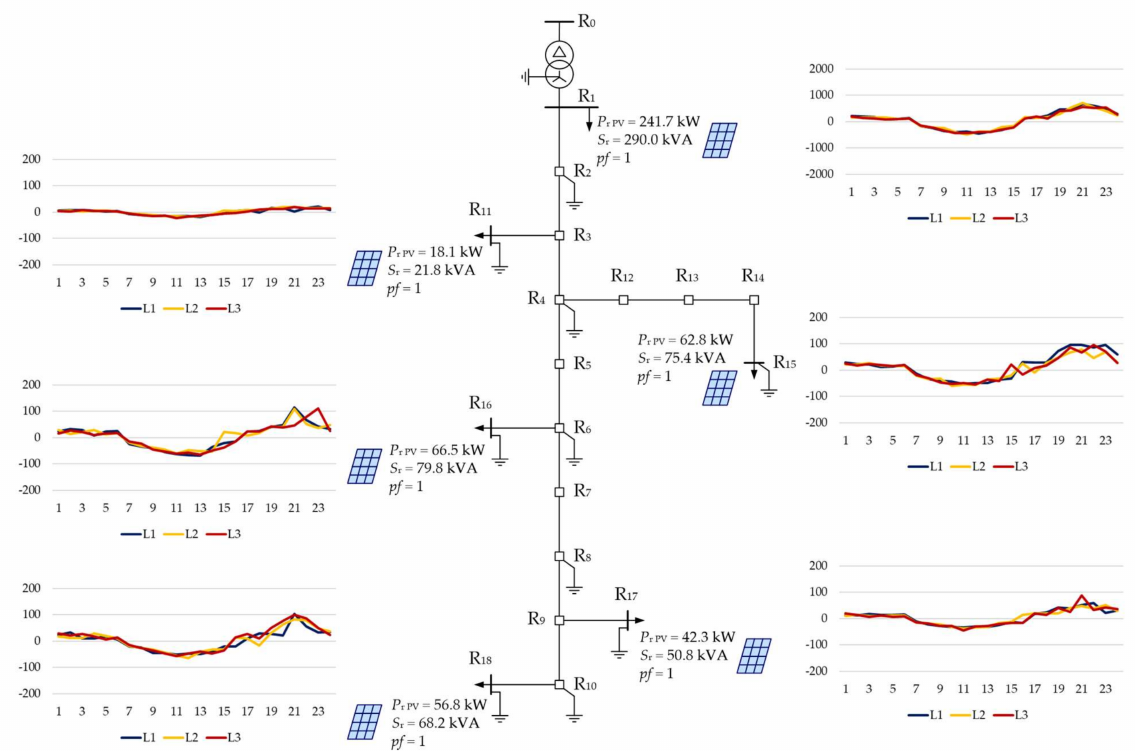
Figure A7. Daily simulation results for variant V7: phase-to-phase voltages (V).